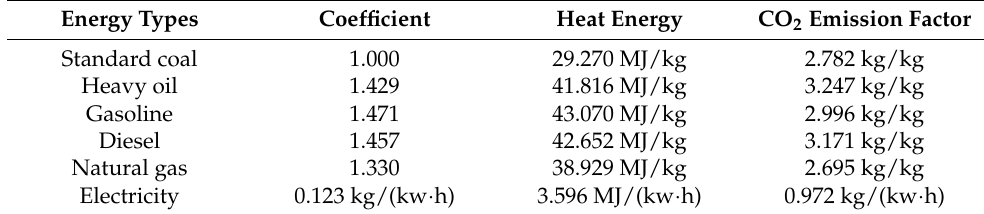
Table 1. Energy inventory involved in road